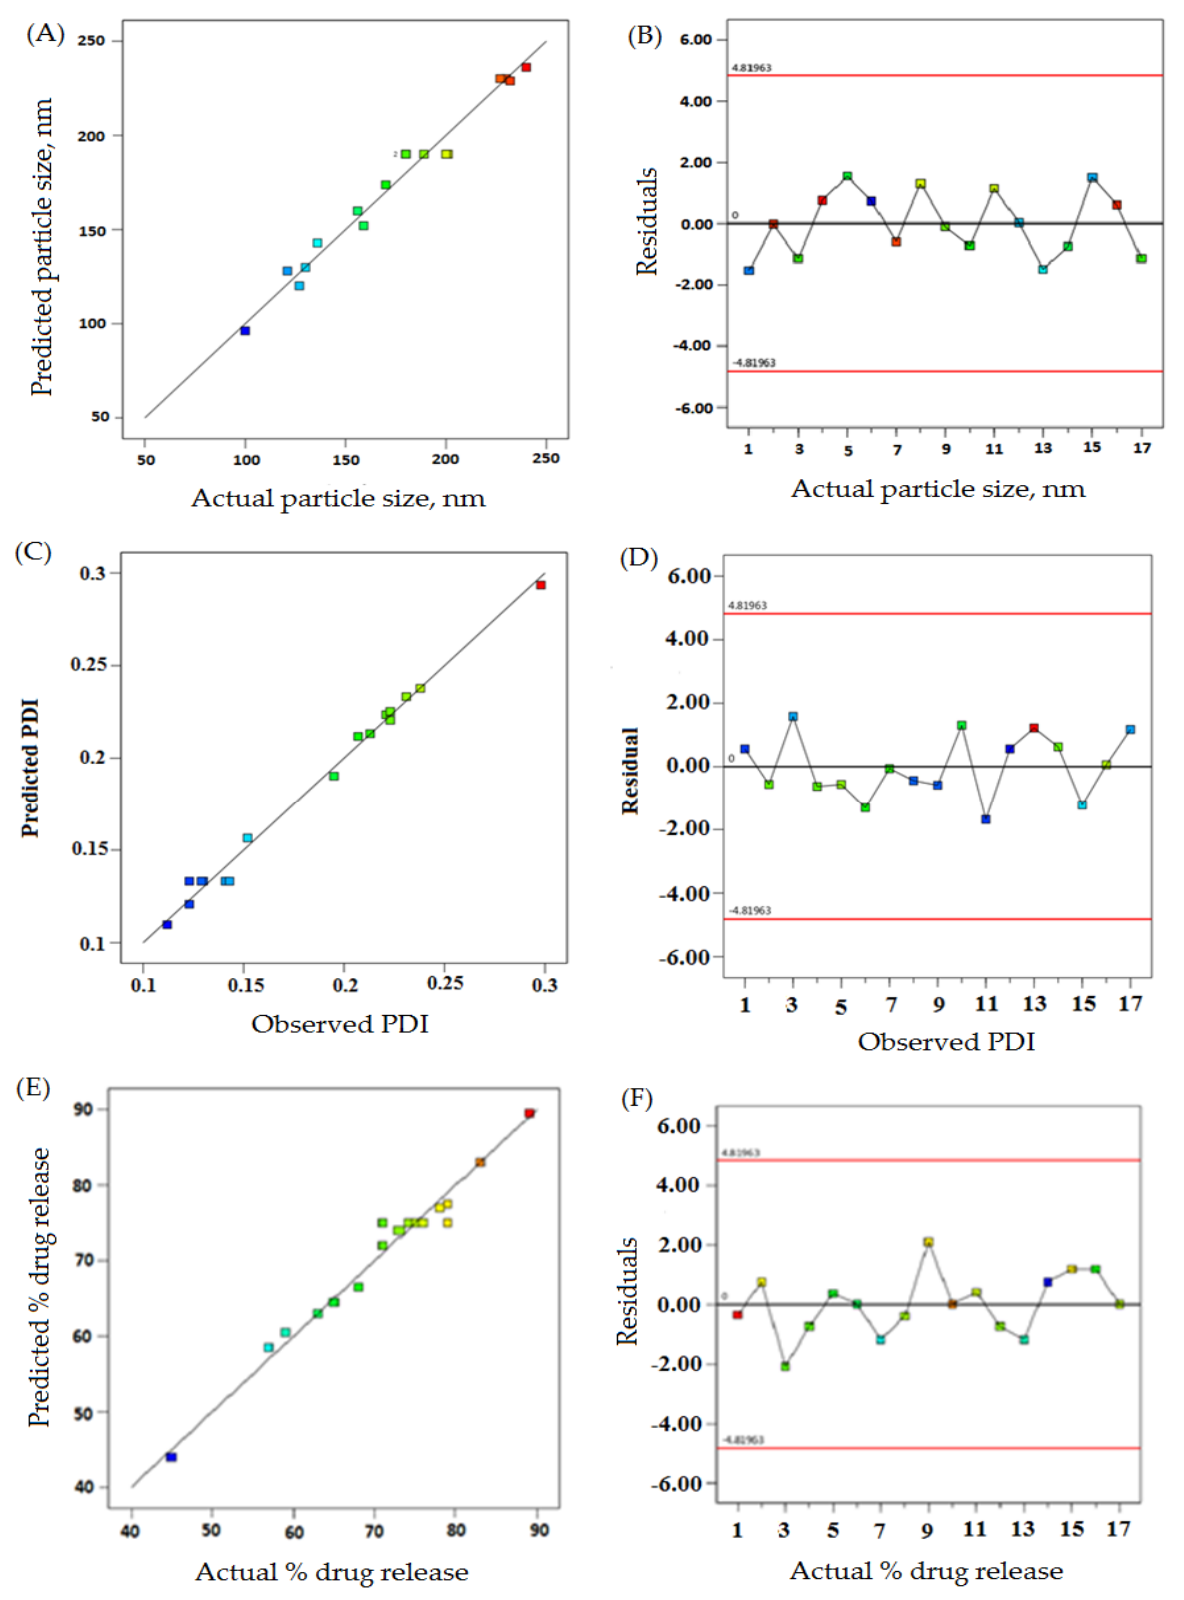
Figure 1. The actual vs. predicted values represented as linear correlation plots ( A , C , E ), and associ- ated residual plots ( B , D , F ) providing responses according to particle size, PDI, and %drug release.